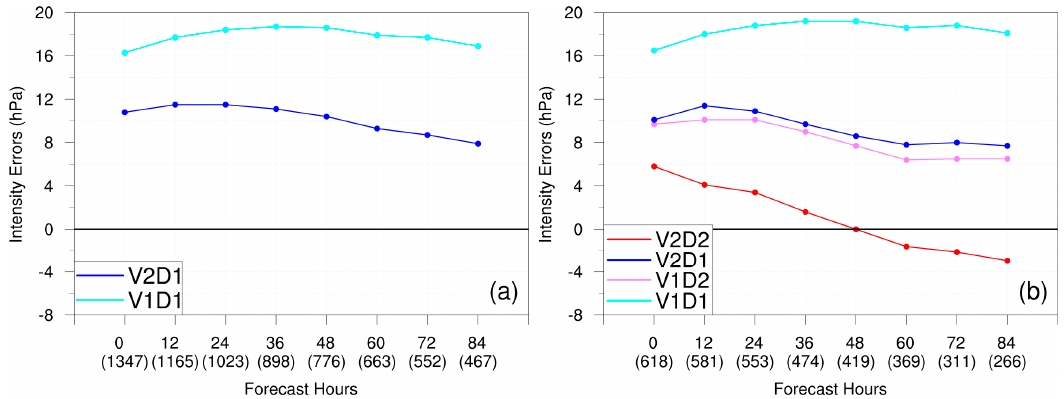
Figure 3. Same as in Figure 2, except for ( a , b ) the cases with intensity (minimum center sea-level pressure) errors.